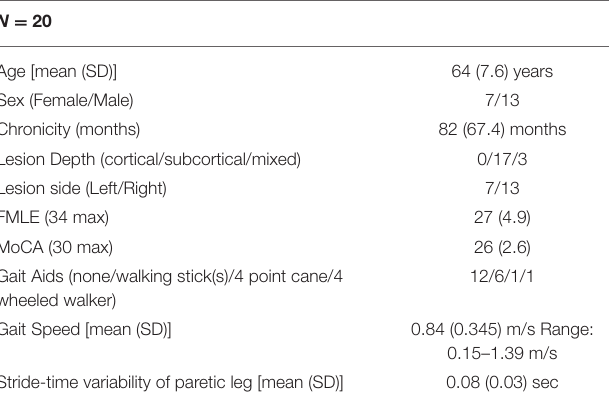
TABLE 1 | Summary of participant demographics and